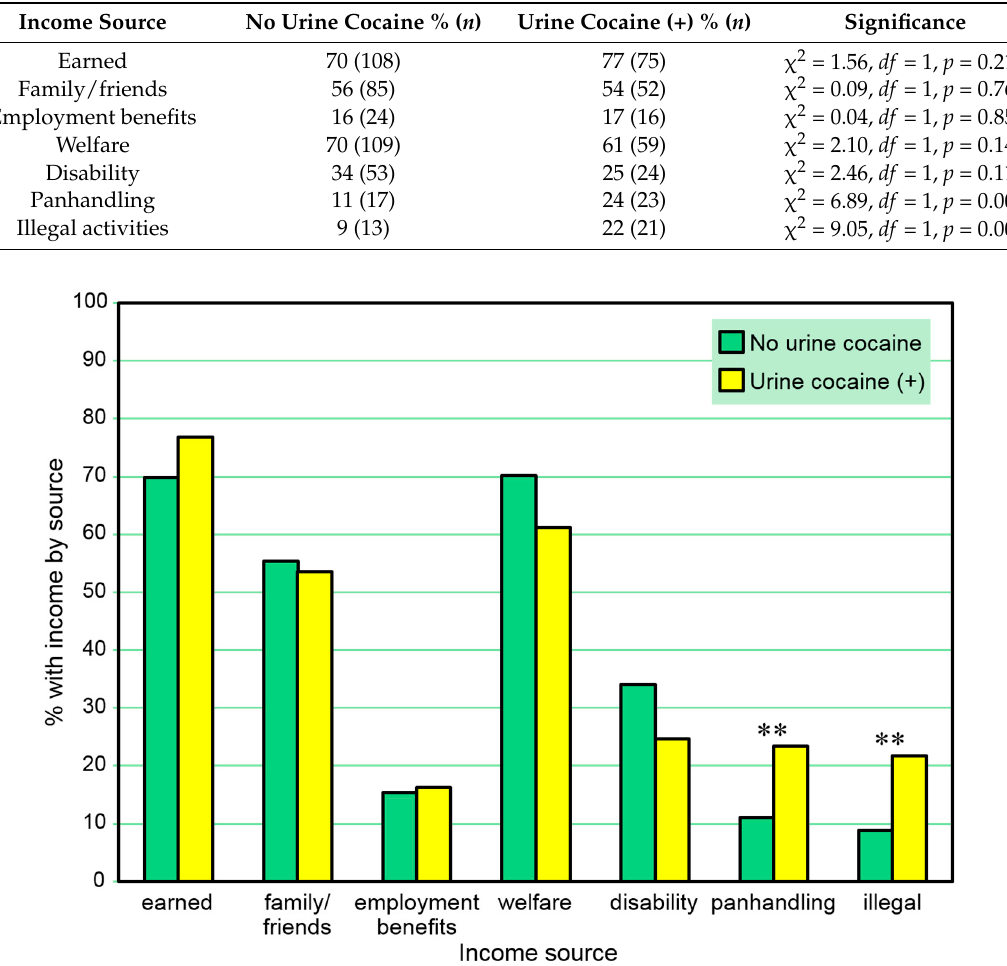
Figure 1. Proportions with 30-day income sources at any time point among those with and without a positive urine cocaine test at any time point. ** p ≤ 0.01.